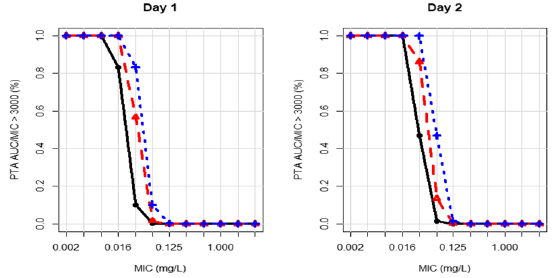
Fig. 1 PTA based on AUC0‑24/MIC ratios > 3000 for different dosing regimens over 2 days. Black lines with filled circles: 100 mg daily. Red dash lines with triangles: 150 mg daily. Blue dash lines with crosses: 200 mg daily. AUC0‑24: Area under curve (0–24 h). MIC: 0.002–4 mg/L